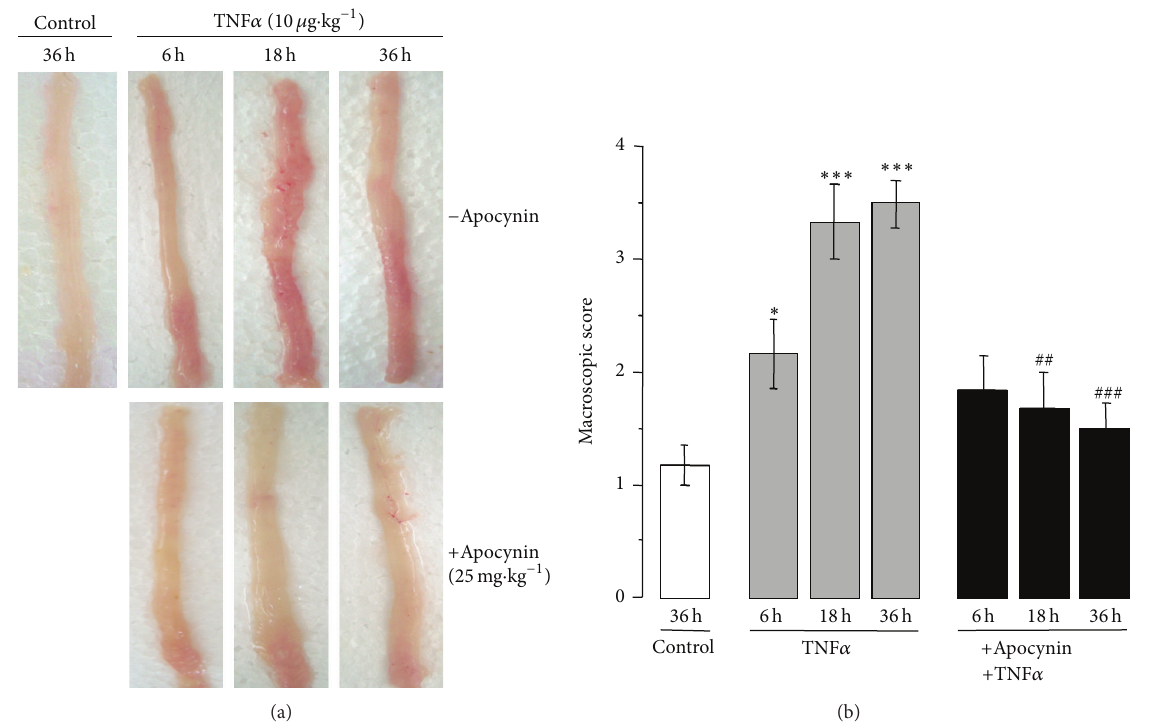
Figure 1: Apocynin improves TNF 𝛼 -induced macroscopic damage of the colon. (a) Macroscopic examination of the colon of mice treated withTNF 𝛼 (10 𝜇 g ⋅ kg −1 ,ip)inthepresenceorabsenceofapocynin(25 mg ⋅ kg −1 ,ip).Apocyninwasgiven30 minbeforeTNF 𝛼 administration. Colons were resected at 6, 18, and 36 hr after TNF 𝛼 treatment. Control mice were given saline and sacrificed at 36 hr; (b) macroscopic score damage in the colon of mice treated with TNF 𝛼 (10 𝜇 g ⋅ kg −1 , ip) in the presence or absence of apocynin (25 mg ⋅ kg −1 , ip). Results from mice treated with 10 𝜇 g kg −1 TNF 𝛼 were matched to control mice with Mann-Whitney’s 𝑈 test. Values are means ± SEM from 𝑛 = 5 mice in each group. ∗ 𝑃 < 0.05 and ∗∗∗ 𝑃 < 0.001 versus control group; ## 𝑃 < 0.01 and ### 𝑃 < 0.001 versus TNF 𝛼 treated group.